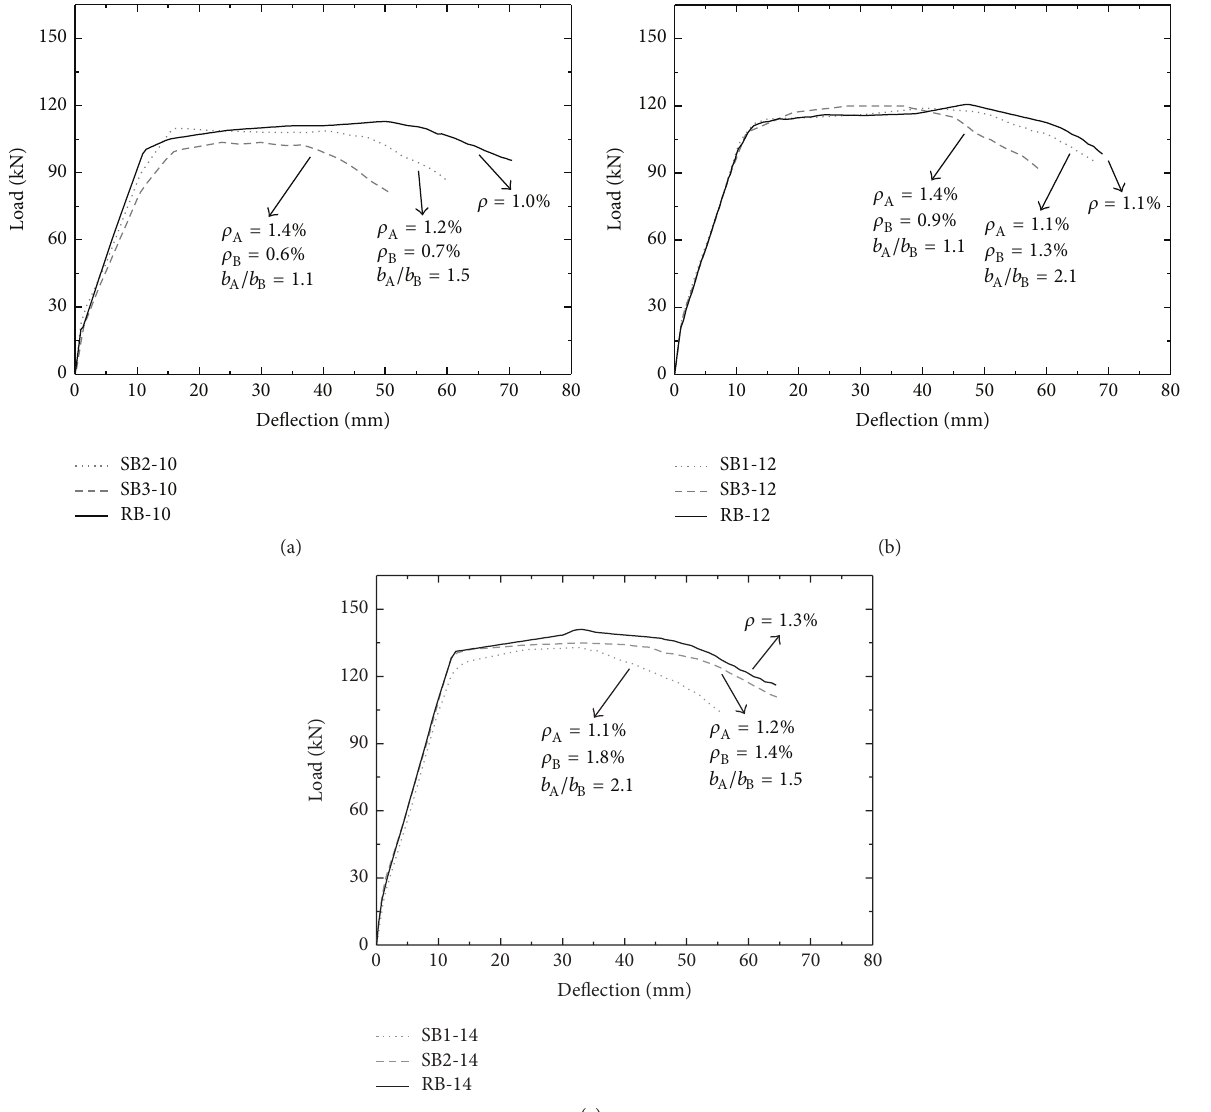
Figure 6: Load-deflection curves of the slotted beams: (a) SB2-10 and SB3-10; (b) SB1-12 and SB3-12; and (c) SB1-14 and